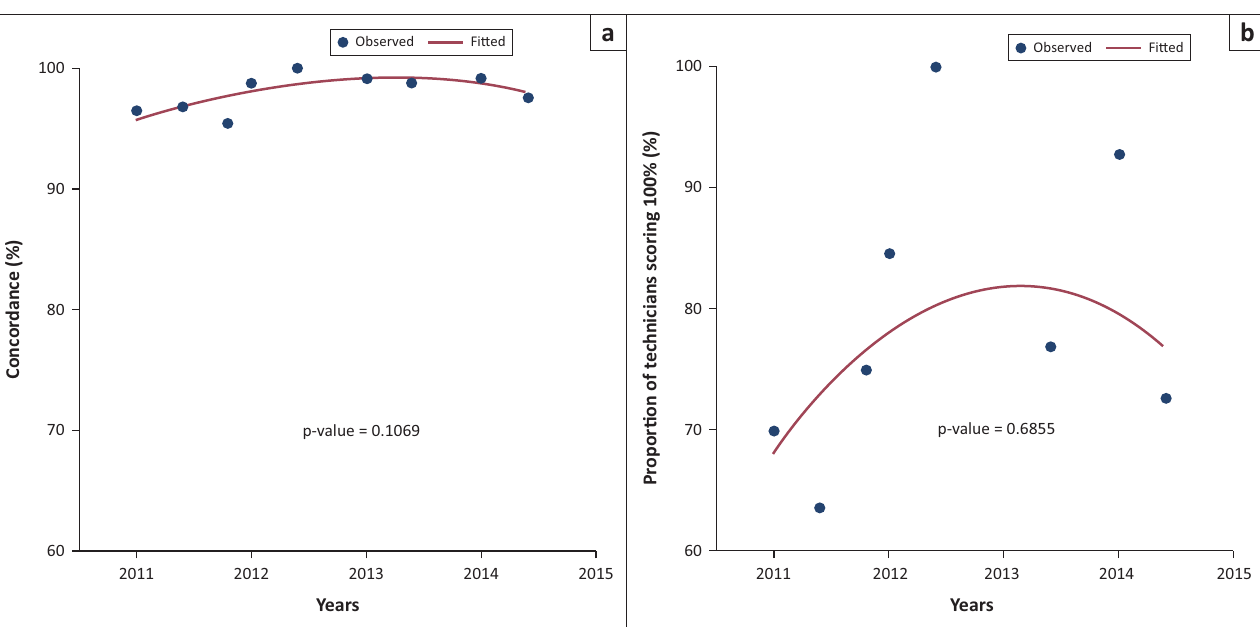
FIGURE 2: Percentage of technicians scoring 100 % versus their concordance during each test panel from 2011–2014. The line is a fit of a beta-binomial regression with linear and quadratic terms of technicians scoring 100 %